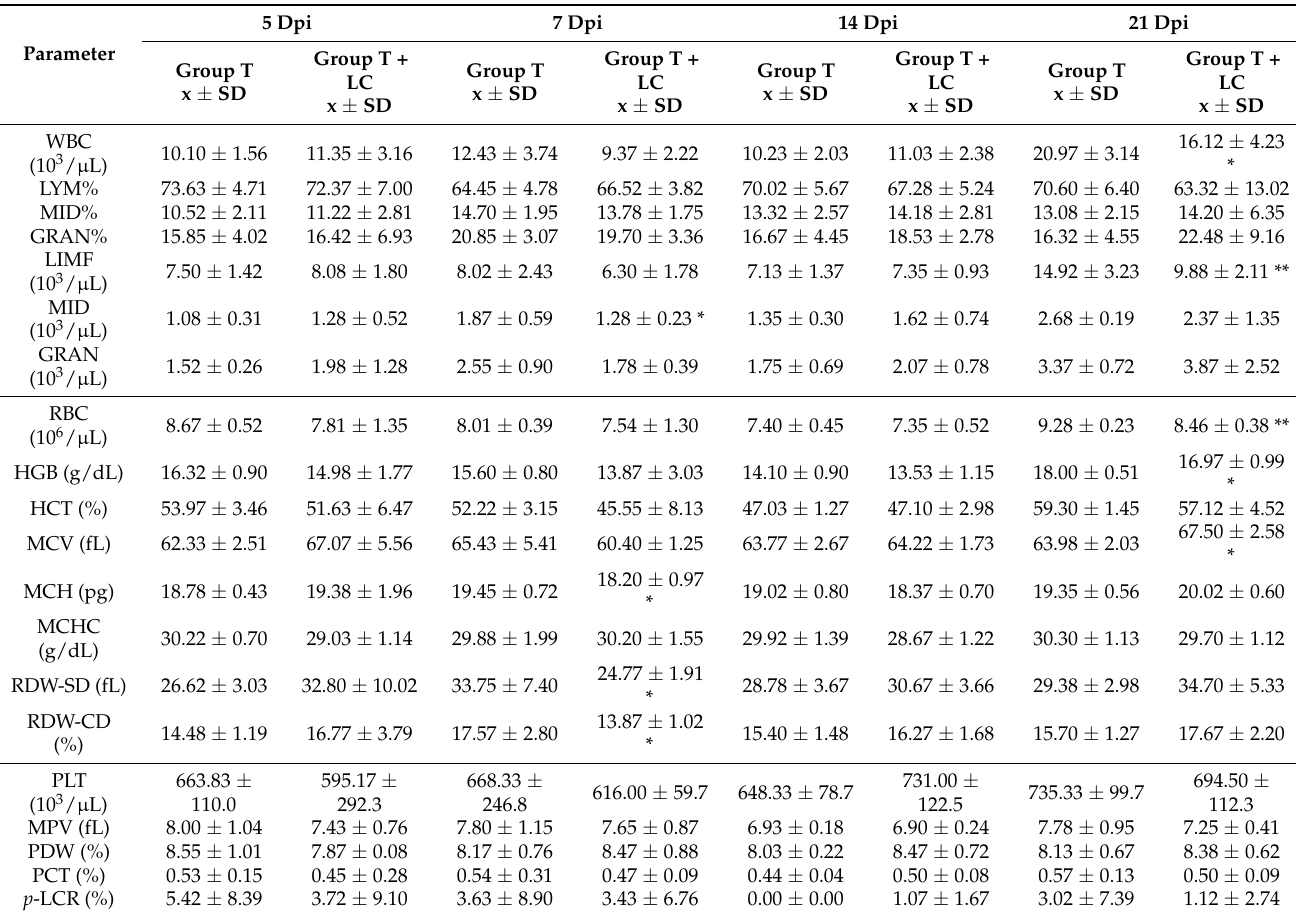
Table 8. Blood parameters in the mice infected with T. spiralis (Group T) and infected with T. spiralis and receiving LC extract (Group T + LC). Mean values ( n = 6) and standard deviations are presented. * p < 0.05, ** p < 0.01.